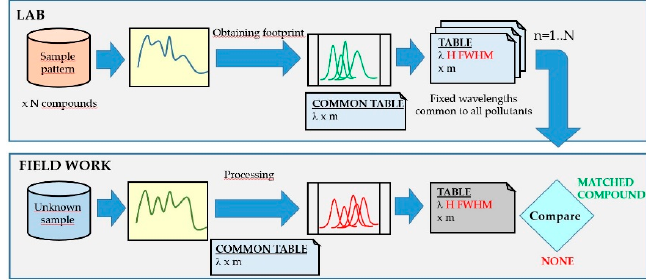
Figure 10. Detection scheme using fluorescence spectra by the proposed method: in the laboratory (upper part of the figure) and in the field analyzer (lower part of the